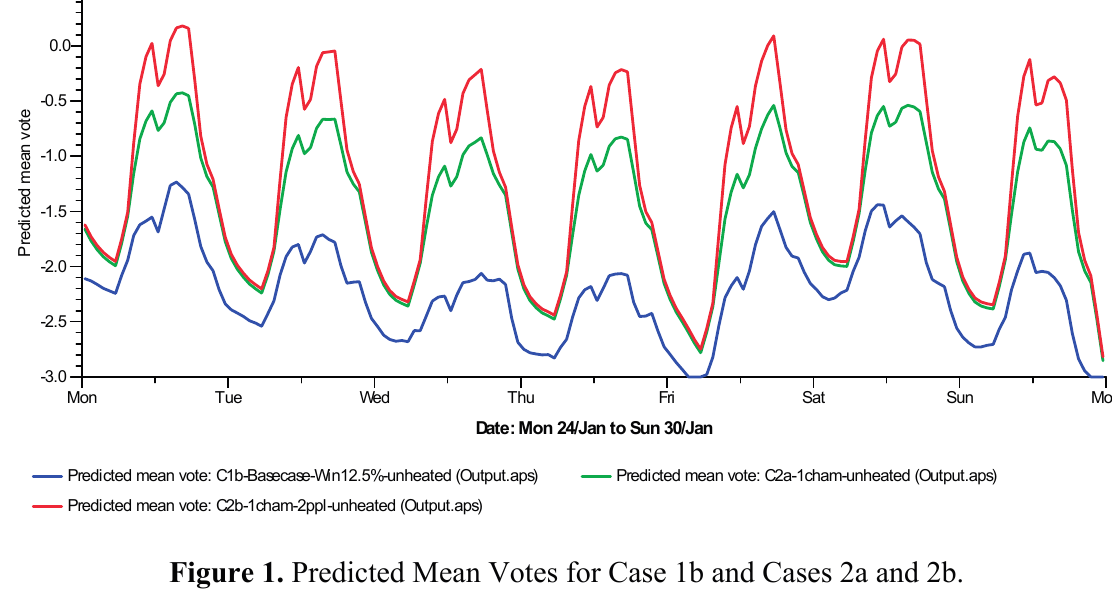
Figure 1. Predicted Mean Votes for Case 1b and Cases 2a and 2b.